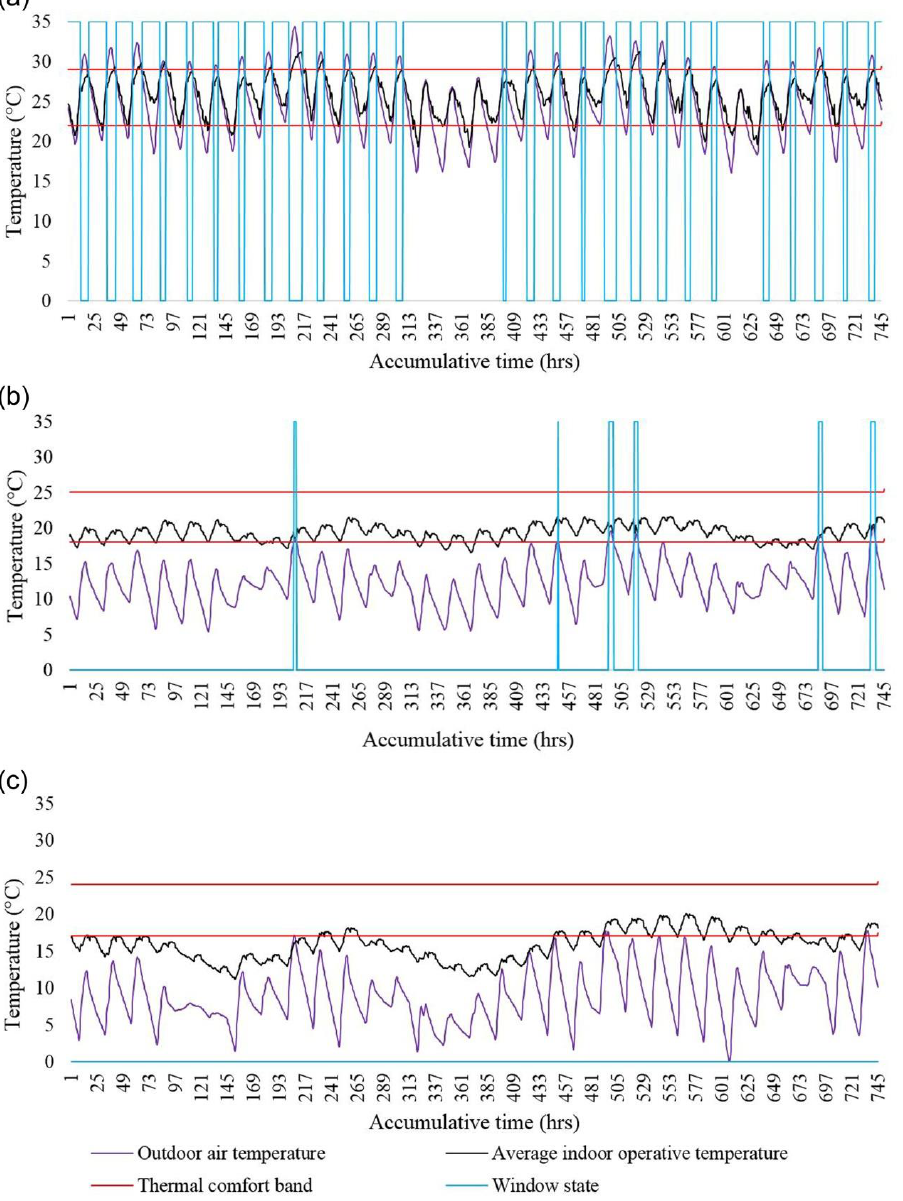
Figure 9. Indoor operative temperature variation during July in: ( a ) Darwin; ( b ) Sydney; and ( c ) Melbourne.